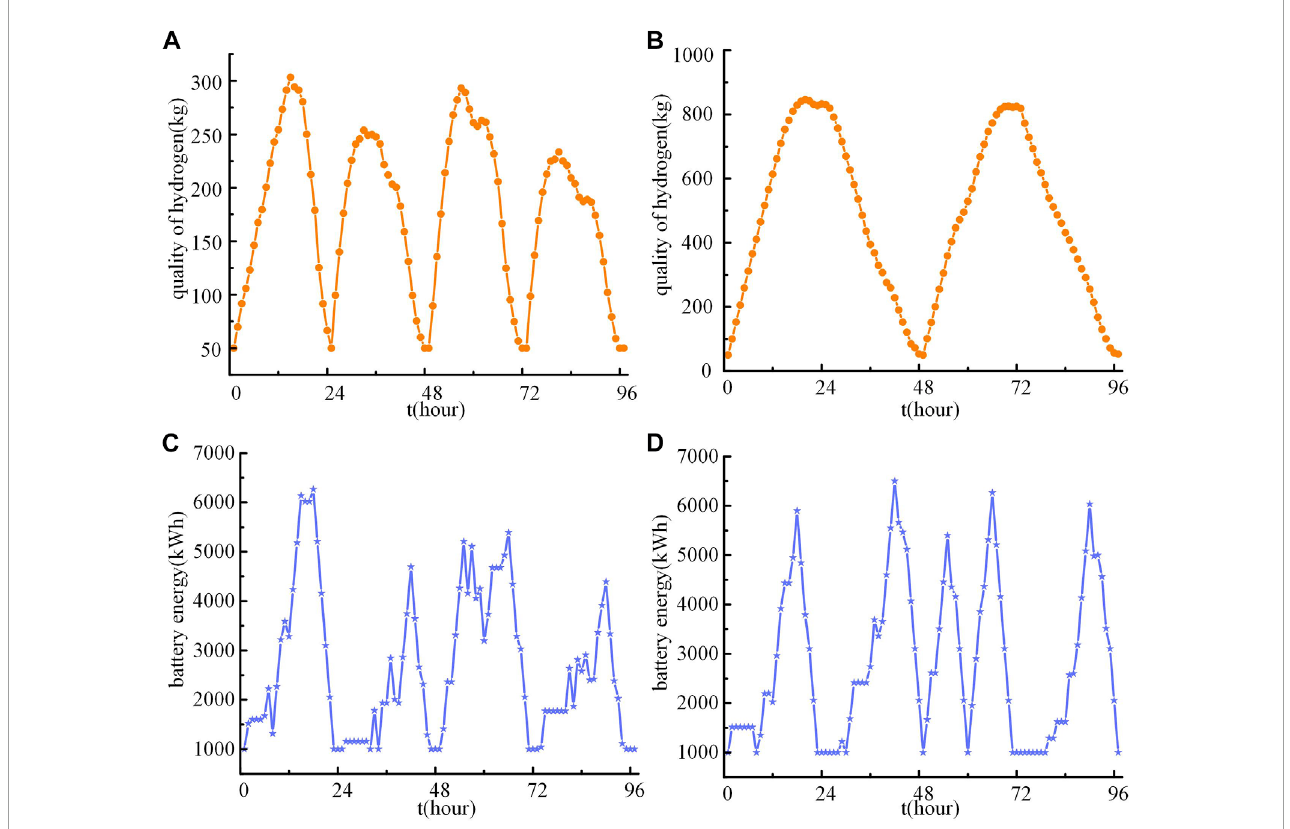
FIGURE 7 HES and EES energy. (A) Case 1 HES. (B) Case 2 HES. (C) Case 1 EES. (D) Case 2